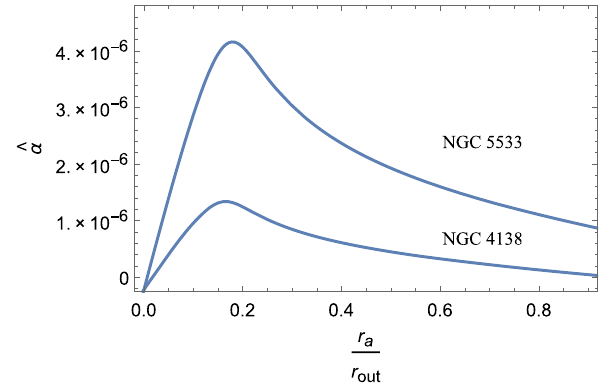
Fig. 5 Light deflection angle curve for NGC 5533 and NGC 4138 plotted with generalised pseudo-isothermal dark matter density profile. The deflection angle increases up to the core radius and decreases in the halo of dark matter background